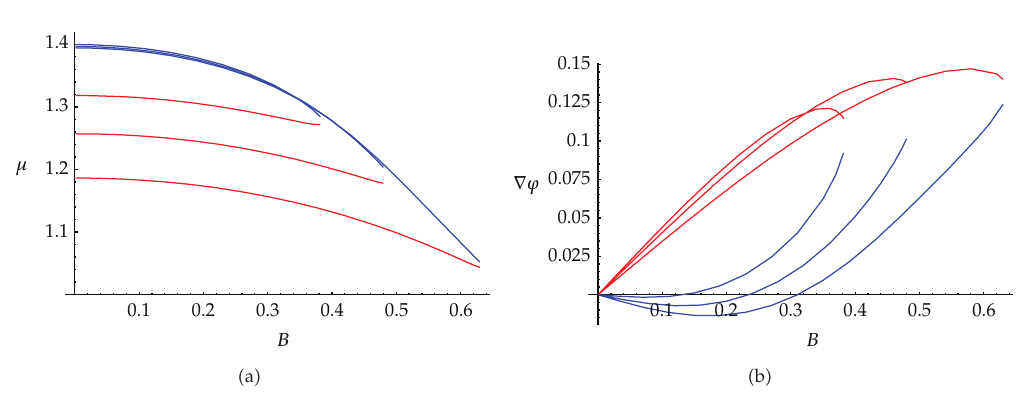
Figure 10: Comparison between the baryon chemical potential (cid:3) a (cid:4) and the pion gradient (cid:3) b (cid:4) as a function of B at fixed j A (cid:8) 0 , d (cid:8) 1 , T (cid:8) 0 . 10; for n s (cid:8) 0 (cid:3) normal baryon (cid:4) , the bottom graph; n s (cid:8) 0 . 10, the middle graph; n s (cid:8) 0 . 20, the top graph. The blue lines are the configuration A with u c close to u T , and the red lines are the configuration B with large separation between u c and u T